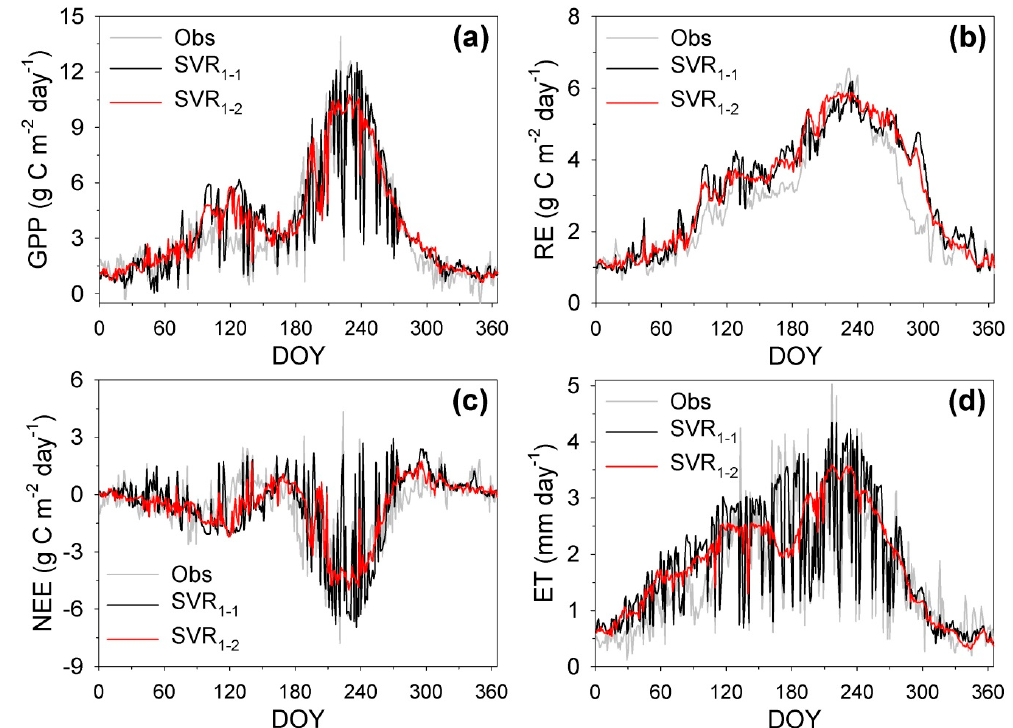
Figure 4. Time series of the daily gross primary production (GPP) ( a ), ecosystem respiration (RE) ( b ), net ecosystem exchange (NEE) ( c ), and evapotranspiration (ET) ( d ) at the study site in 2009 from the observations (Obs) and the SVR ‐ based model from Experiments 1 ‐ 1 (SVR 1 ‐ 1 ) and 1 ‐ 2 (SVR 1 ‐ 2 ).